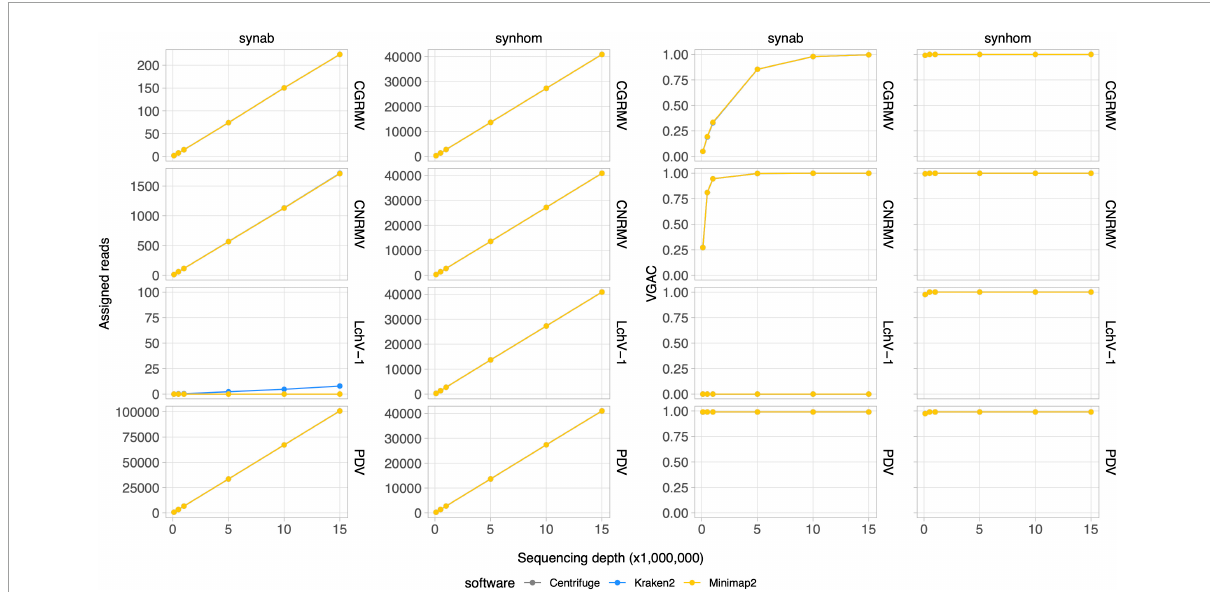
FIGURE3 Read assignment and coverage in synthetic data. Synthetic HTS data were generated to simulate actual samples. The Pavium panel-I comprising 11 viral genomes was used to build samples containing 3% of viral reads from a 20 million paired-end reads. Samples were built with both a homogeneous distribution of viral reads ( synhom ) and based on an average distribution of actual samples ( synab ) ( Supplementary Tables 2 , 3 ). In all cases, 10 subsets of randomly selected reads were built at different depths of sequencing. Assigned reads are shown in the two first column charts and VGAC is shown in the last two column charts. A full version containing all of the target viruses is depicted in Supplementary Figure 3 . Average values (dots) as well as standard deviations are listed in Supplementary Table 11 . VGAC, viral genome assembly coverage; CGRMV, cherry green ring mottle virus; CNRMV, cherry necrotic rusty mottle virus; LChV-1, little cherry virus 1; PDV, prune dwarf